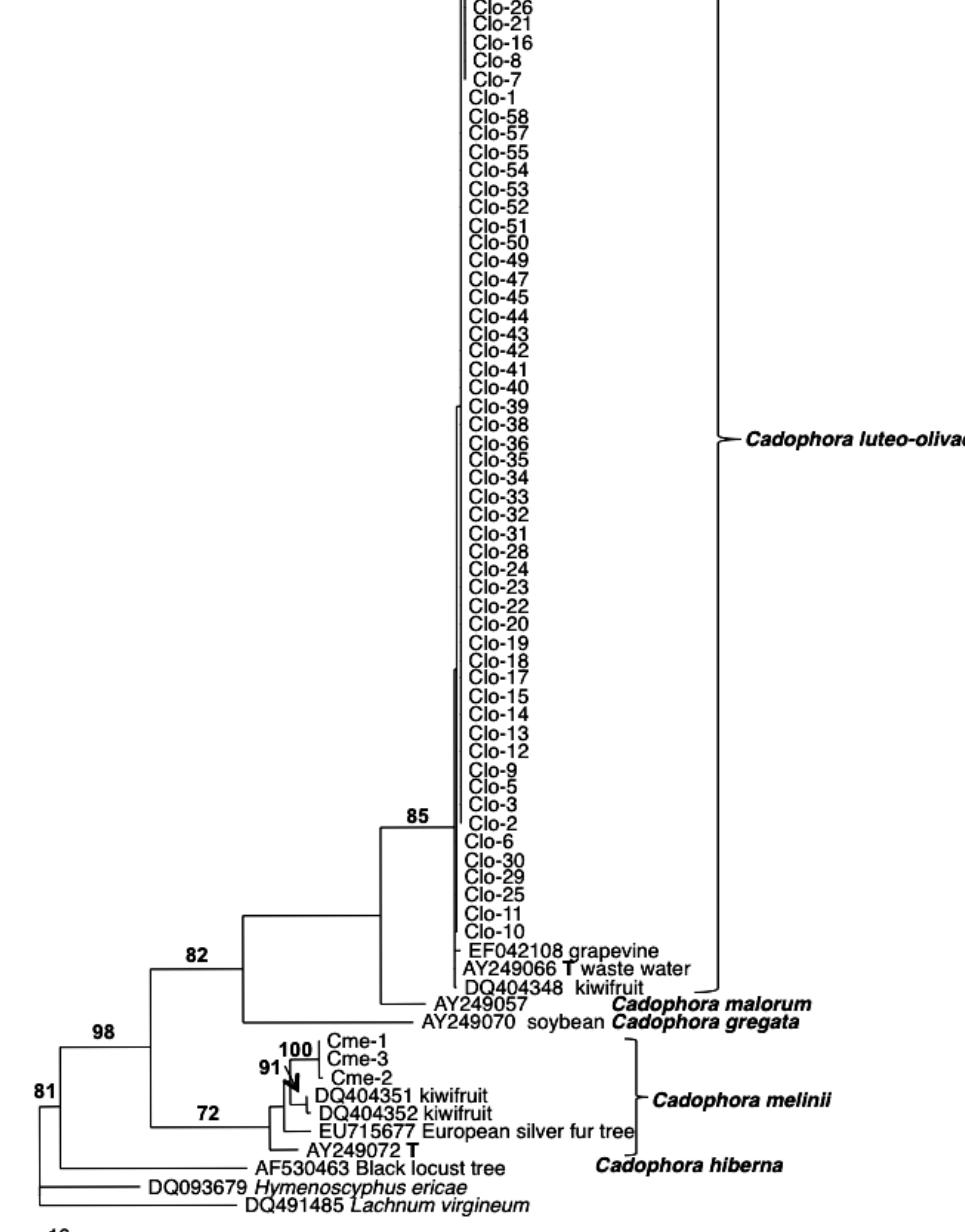
Figure 5. One of the 24 most parsimonious trees obtained from heuristic searches of ITS sequences (Length=312 steps; CI=0.853; RI=0.892; RC=0.761). Bootstrap support values above 65% are shown at the nodes as well as the probability values. Hymenoscyphus ericae and Lachnum virgineum were used as outgroups. Sequences marked with Clo and Cme were generated in this study and were isolated from grapevines. A ‘T’ indicates the sequence of the ex- type culture of the